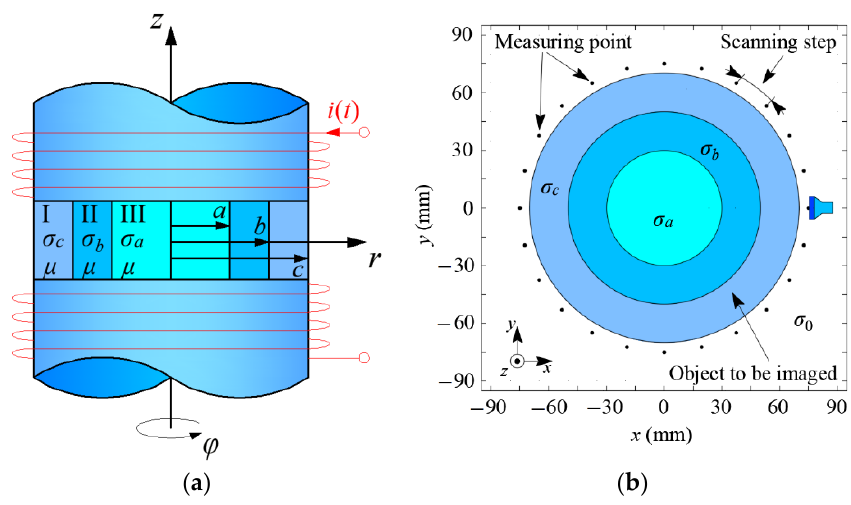
Figure 2. Three-layer cylindrical objects with different conductivities, ( a ) cross-section view, and ( b ) top view.